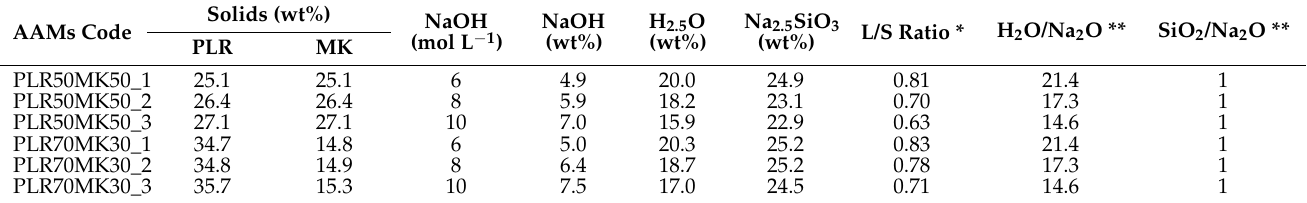
Table 3. Experimental parameters for the synthesis of